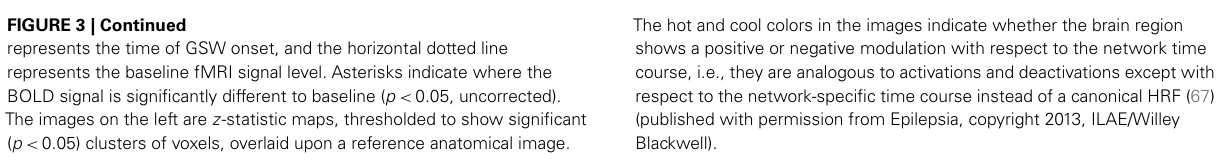
FIGURE 3 | Continued represents the time of GSW onset, and the horizontal dotted line represents the baseline fMRI signal level. Asterisks indicate where the BOLD signal is significantly different to baseline ( p < 0.05, uncorrected). The images on the left are z -statistic maps, thresholded to show significant ( p < 0.05) clusters of voxels, overlaid upon a reference anatomical image.